Question: Looking at the figure, what chart type is it?
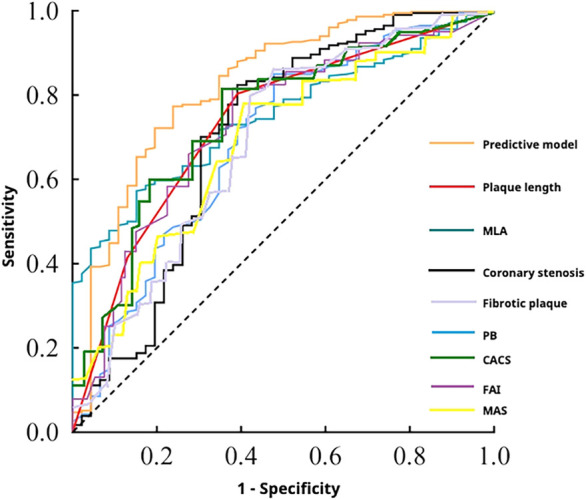
Answer: line